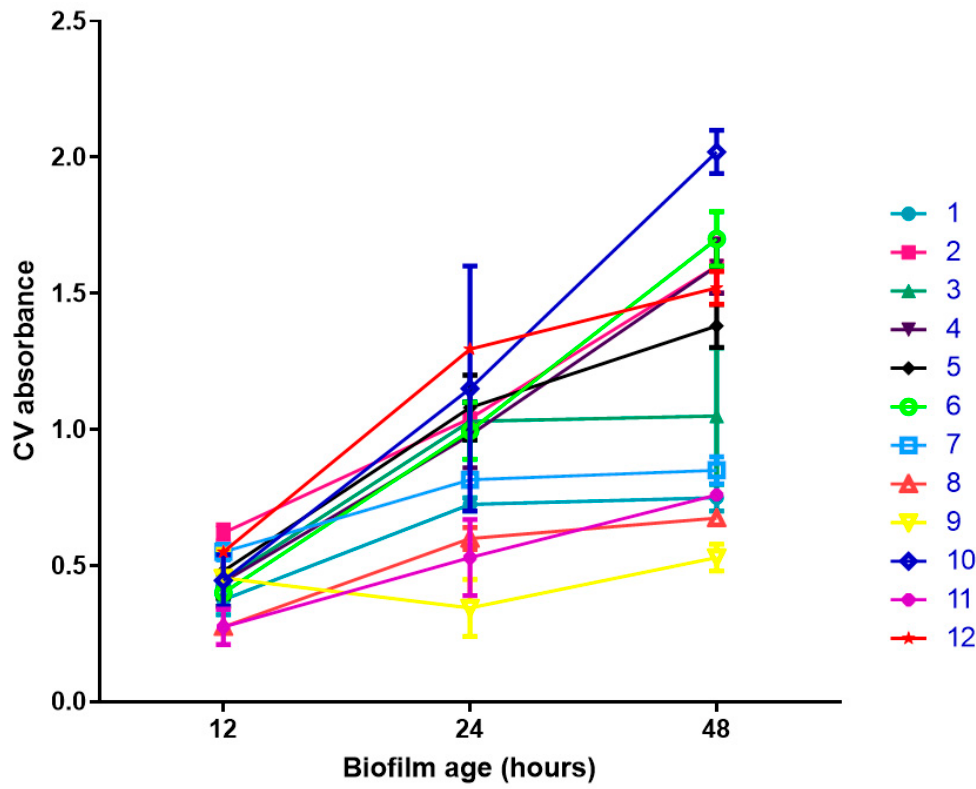
Figure 1. Ability to form biofilm for the 12 clinically isolated P. aeruginosa strains. Biofilm was evaluated at 12, 24, and 48 h. CV absorbance measures biofilm formation. Each colored line (numbers from 1 to 12, see Table 1) refers to a different P. aeruginosa strain.